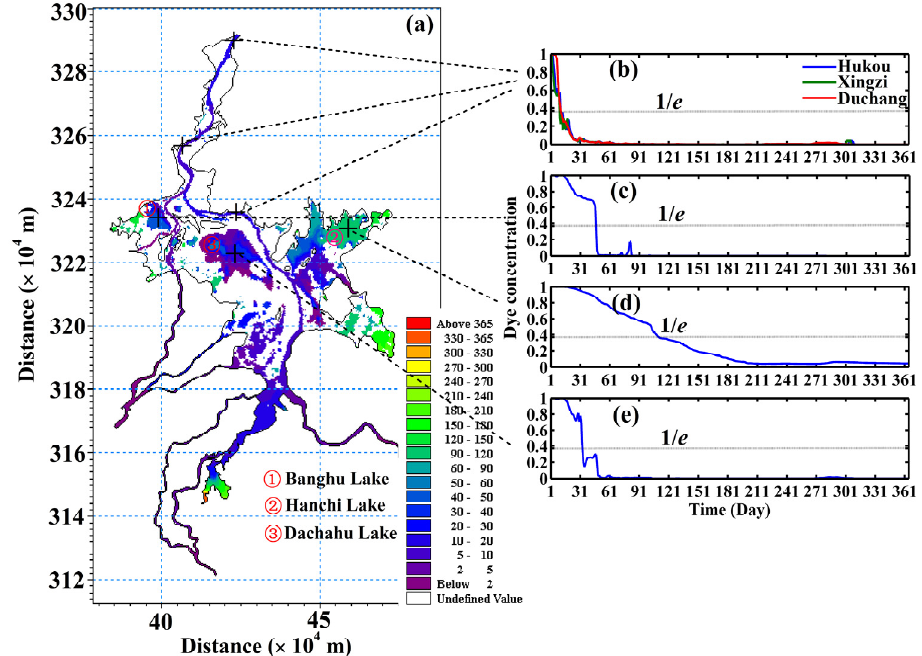
Figure 12. ( a ) Spatial distribution of the depth-averaged residence times (in days) for the low water level period; ( b – e ) the computed dye concentrations with time (in kg/m 3 ) for areas of interest. Releases were performed on the 1st of January during the winter. Note that the “Undefined Value” represents dry land.